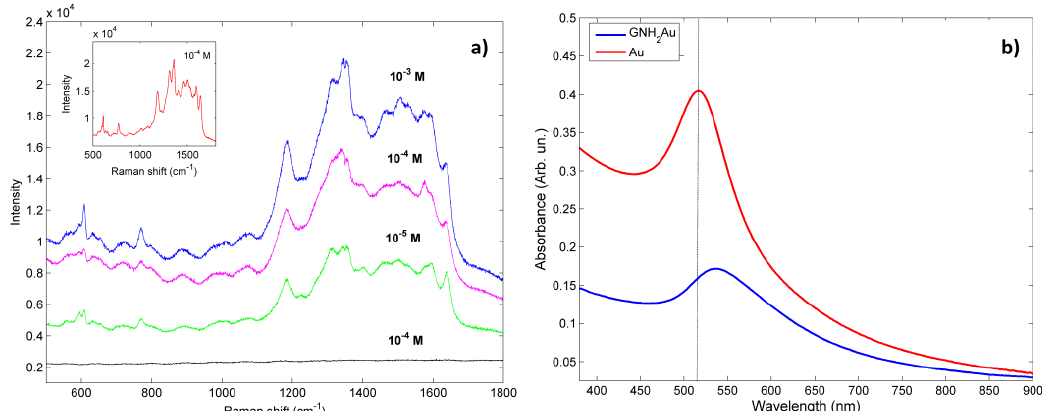
Figure 8. ( a ) SERS spectra of Rh6G (10 − 5 , 10 − 4 and 10 − 3 M) onto G-NH 2 /Au platform; G-NH 2 platform (10 − 4 M, black line) and AuNPs film (10 − 4 M Rh6G reported in the inset), by using the 638 nm laser excitation. ( b ) Optical absorption spectra of freshly prepared Au NPs (red line) and G-NH 2 /Au (blue line, 0.4 mg/mL).